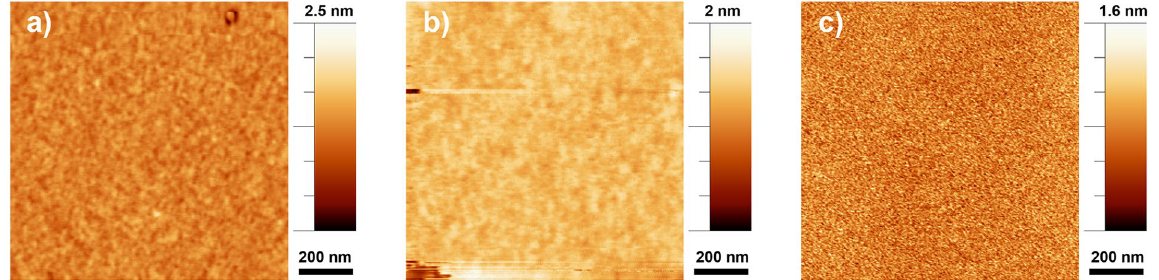
Figure 2. AFM images (on an area of 1 μ m × 1 μ m.) of the TiO 2 films realized with the three different